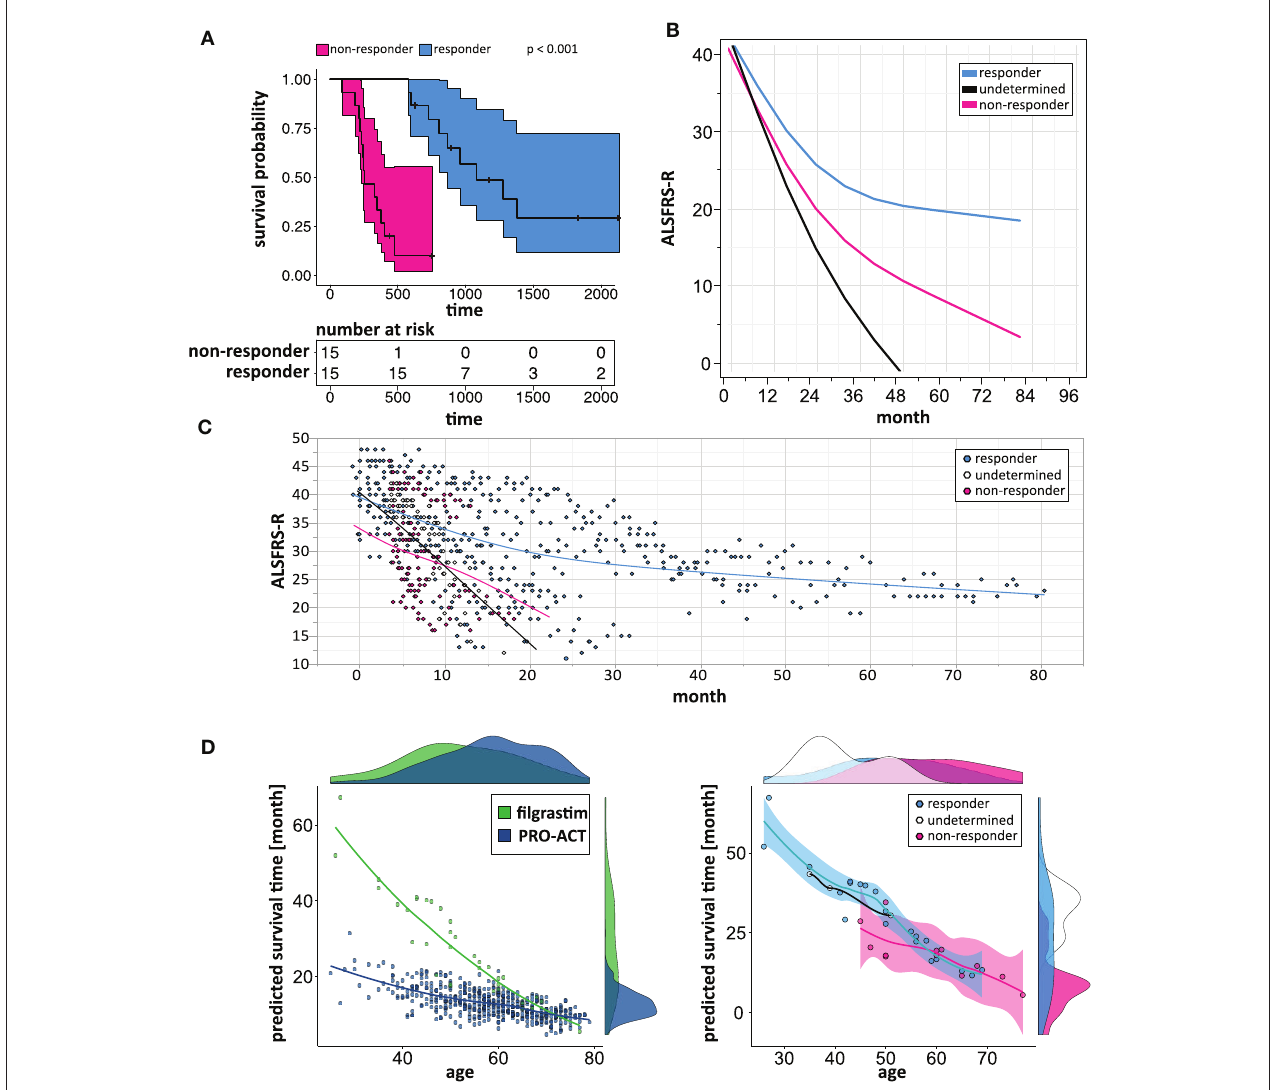
FIGURE 4 | Modeling to identify individual patient response. (A) Kaplan–Meier plots of responding and non-responding patients from Figure 3B . Kaplan–Meier survival plot of responding (turquoise, N = 15) and non-responding (pink, N = 15) filgrastim patients with shaded pointwise 95% CIs. Model-identified responders had a significant survival benefit over non-responders with 1,378 vs. 337.5 days median survival ( p < 0.0001, log-rank test). (B) Estimated ALSFRS-R courses in different filgrastim response groups. Interaction profile of estimated ALSFRS-R score time courses in the different filgrastim response groups with responding patients given by turquoise color, non-responding by pink, and non-assignable patients indicated by black color. A slowing of functional decline is impressive in responders. An increasing difference in functional decline—depending on individual filgrastim response—was revealed by the significant interaction term month * responder group ( p < 0.0001). (C) ALSFRS-R scores over time in different filgrastim response groups. ALSFRS-R scores over time in individual filgrastim-treated patients with responding patients given by turquoise color, non-responding by pink, and non-assignable patients by white color. The interaction term from (B) is valid here too. (D) Individual model-predicted survival times depending on age. The individual predicted patient survival (dots) dependent on age is illustrated in filgrastim (green) and rp-PRO-ACT patients (blue, both in first graph), and within filgrastim-treated patients (responding: turquoise, non-responding: pink, and non-assignable patients: white color; all second graph). The smooth curves of the second graph represent the model-predicted survival times (y-axis), dependent on age (x-axis). The first graph indicates that especially younger ALS patients benefit from filgrastim treatment but that a treatment benefit might be expected up to ∼ 60 years of age. The second graph illustrates the filgrastim response groups and supports this assumption but also shows that the filgrastim-responding group contains patients up to ∼ 70 years of age; the response assessment of these patients can only be fully understood as additional covariates beyond age have been taken into